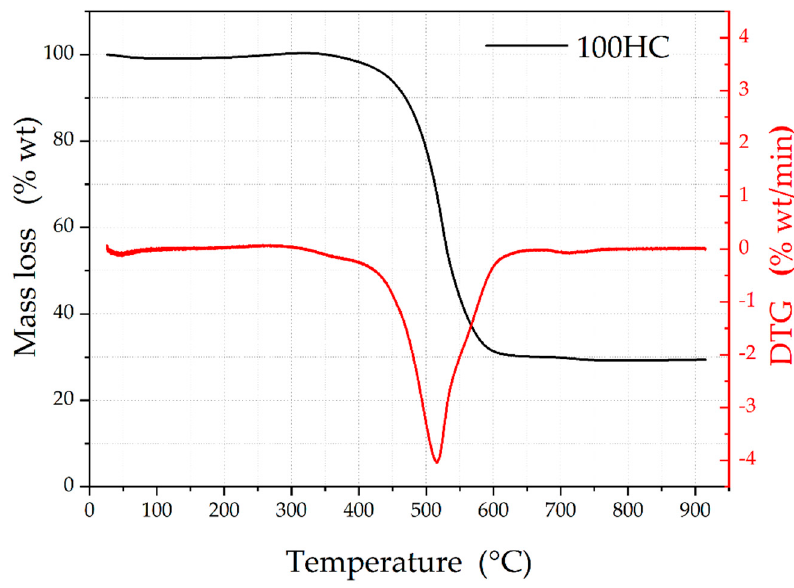
Figure 1. TG/DTG curves for 100HC at 5 °C/min heating rate under an air atmosphere.